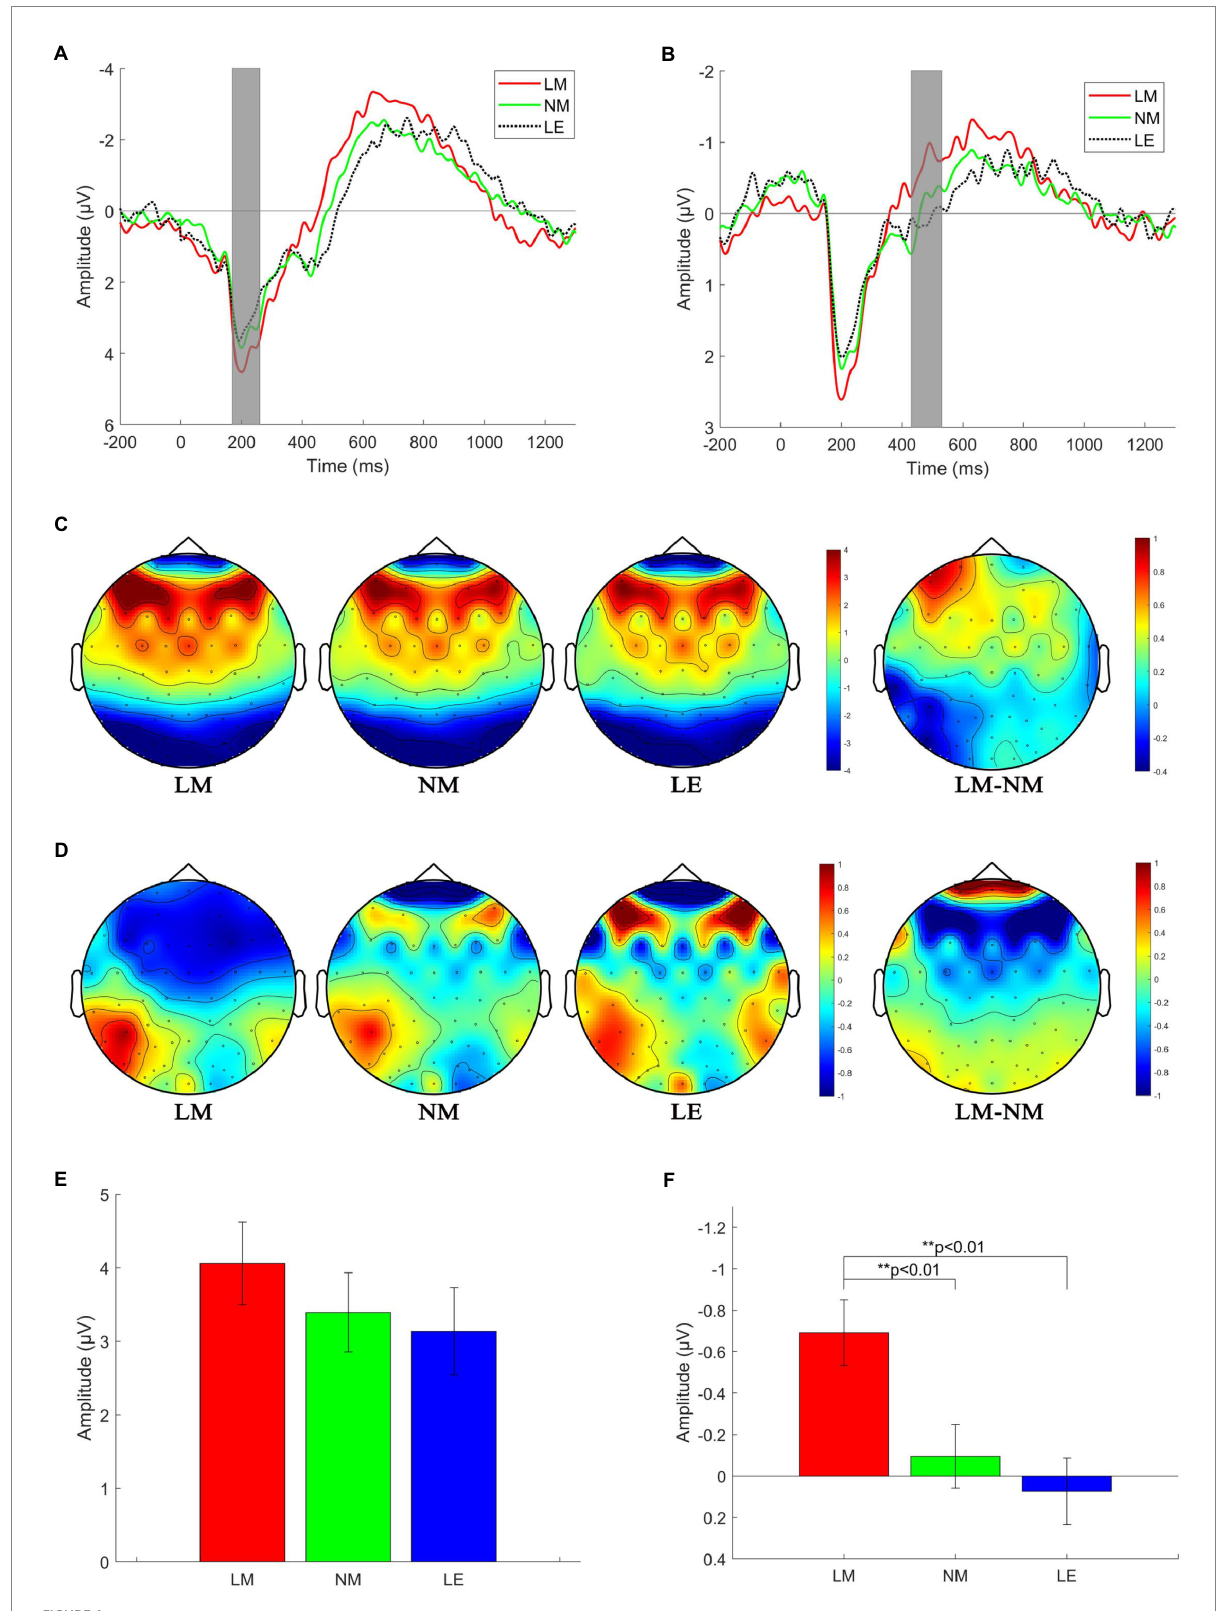
FIGURE 4 ERP responses to three stimulus conditions. (A) Grand average ERP of P200 channels. (B) Grand average ERP of N400 channels. (C) Topographies in P200 time window. (D) Topographies in N400 time window. (E) Mean values and standard error of the P200 amplitude in the three conditions. (F) Mean values and standard error of the N400 amplitude in the three